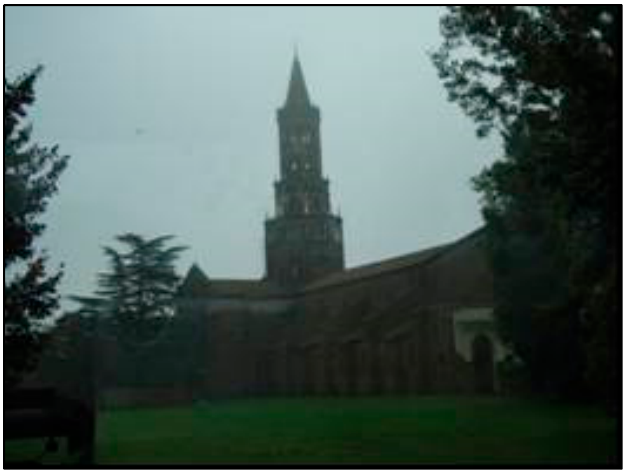
Figure 17. Chiaravalle abbey, near Milan, Italy (photo by M. Salgot).